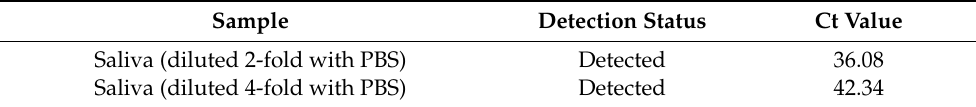
Table 4. qPCR results using saliva (without RNase P synthetic RNA